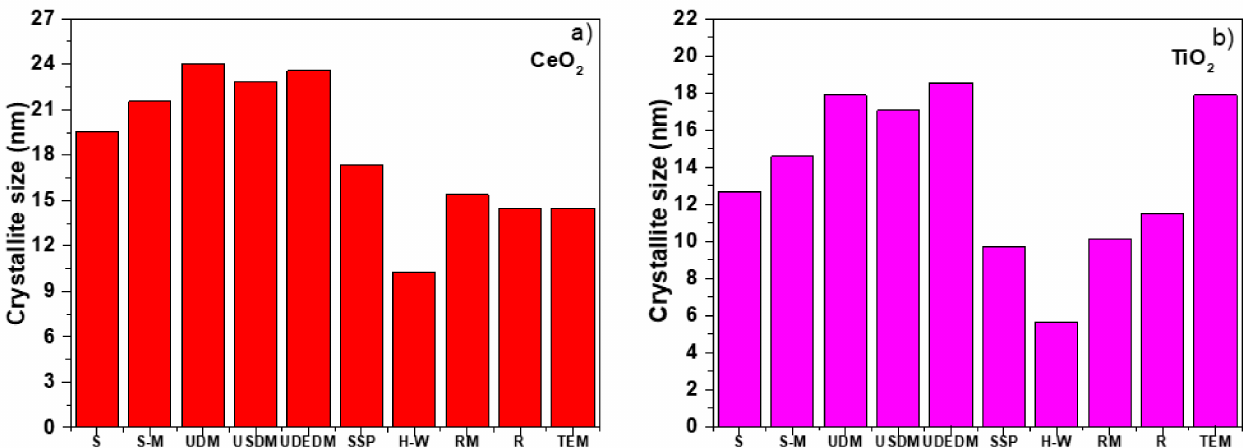
Figure 9. Comparison of the average crystallite size obtained by different estimation methods S (Scherrer method), RM (Rietveld Refinement), and R ( µ -Raman) for CeO 2 ( a ) and TiO 2 NPs ( b